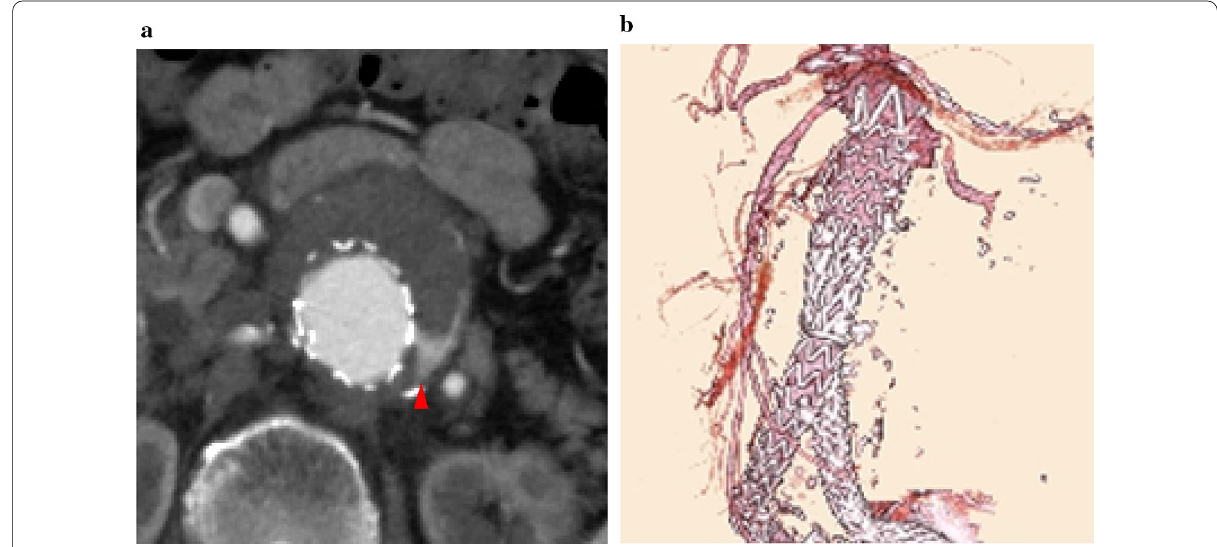
Fig. 1 a The axial image of the postoperative computed tomography revealed a type Ia endoleak (arrowhead). b The 3D image of the postoperative computed tomography revealed a migration of the stentgraft